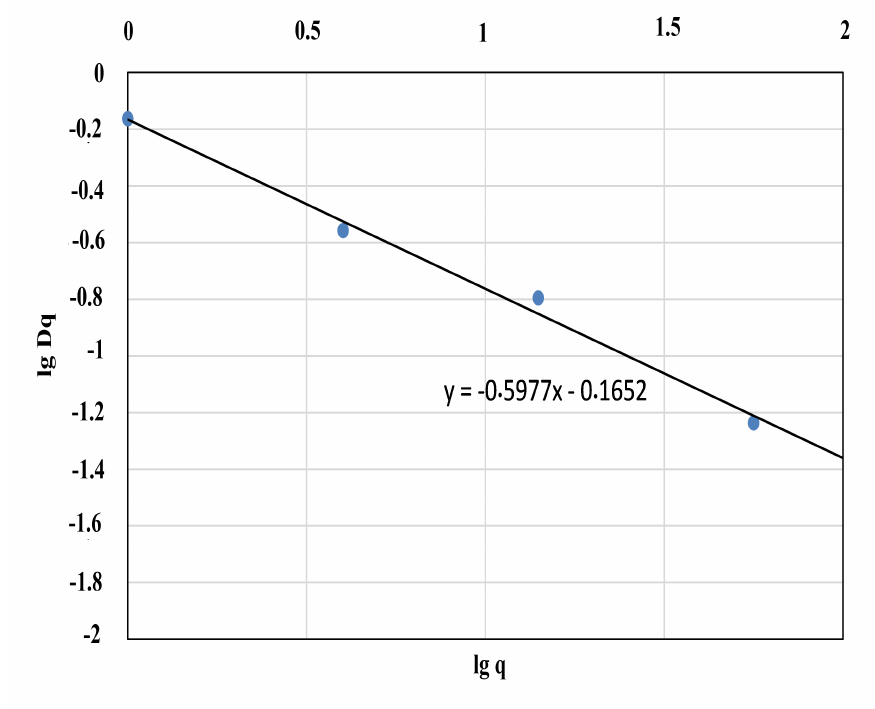
Figure 8. Dependence of the variance of aggregated structures on the size of the aggregation